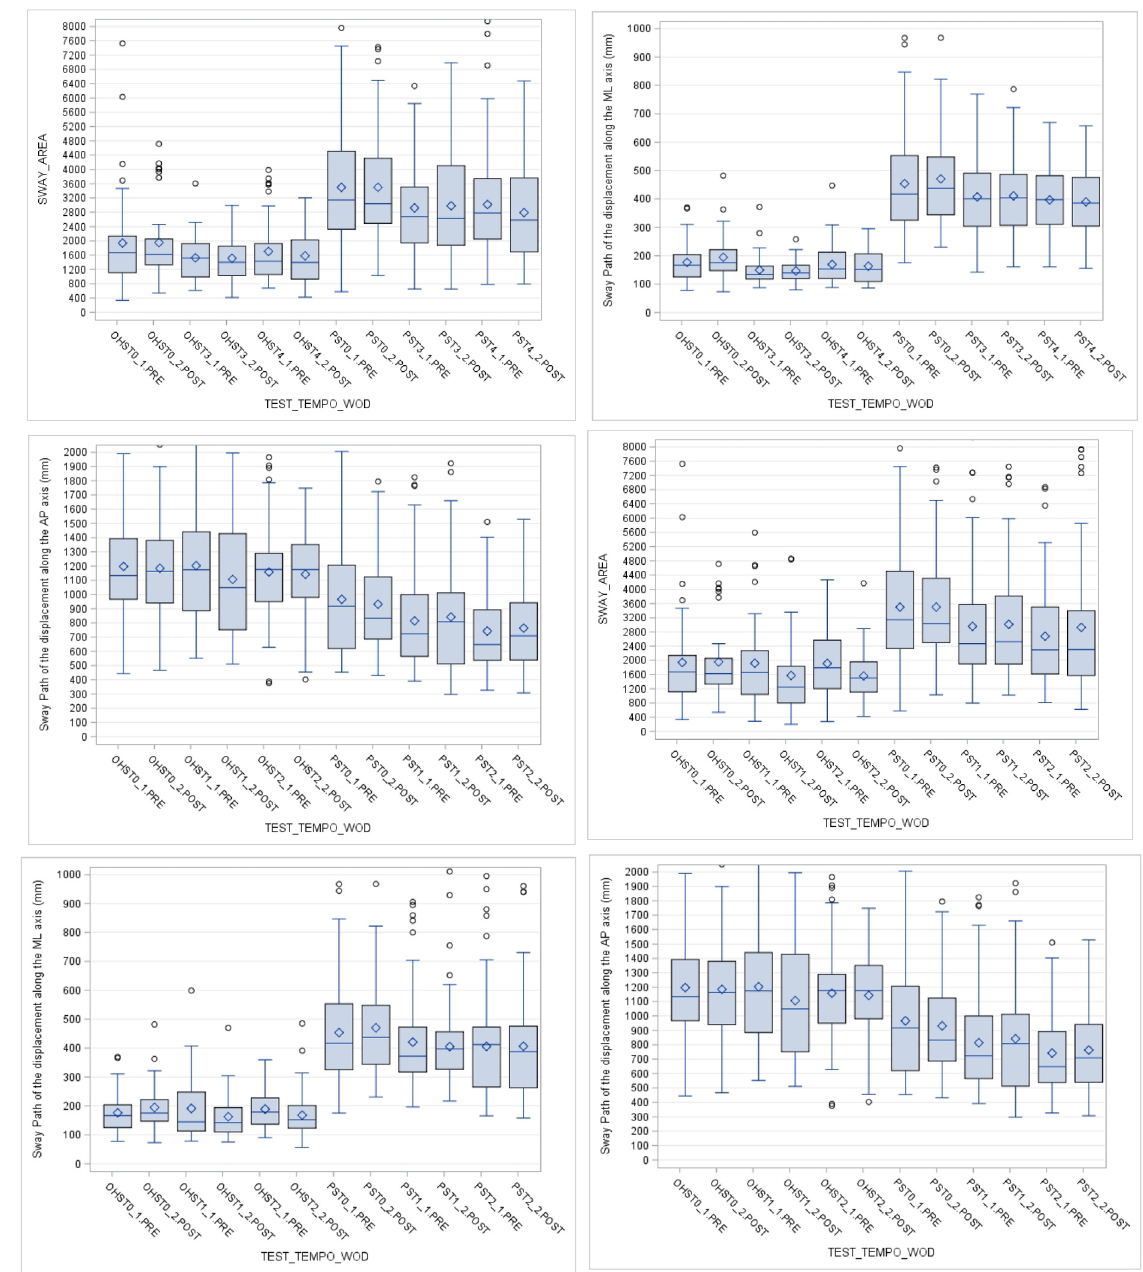
Figure 4. In the following figure is shown an example of how both CFOs affected the sway area indexes in the dynamic movement PS, reducing balance oscillations. Boxplots represent principal dispersion indexes (IQ range, mean and median) values before and after the use of CFOs comparing the moment without CFO (T0) with the first use (T1 or T3) and medium term (T2 or T4) measurements. It can be noticed that there is a reduction in the mean and variability (IQ range) of the oscillations (SA, DML, APD), especially in PS movement. The reduction in OHS is less significant.